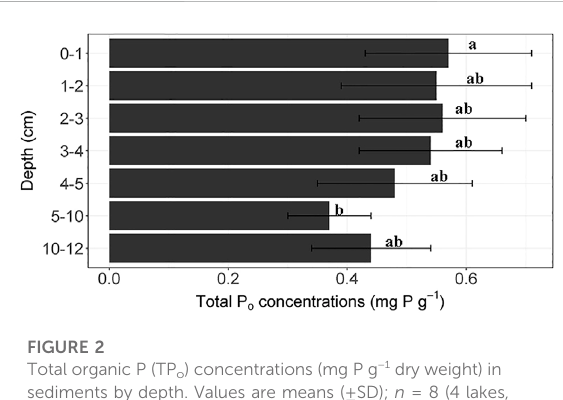
FIGURE 2 Total organic P (TP o ) concentrations (mg P g − 1 dry weight) in sediments by depth. Values are means (±SD); n = 8 (4 lakes, duplicate cores). Different letters indicate signi fi cant differences ( p < 0.05) in the P o concentrations among the depths and lakes, determined by Kruskal-Wallis tests followed by pairwise Wilcoxon tests with Bonferroni